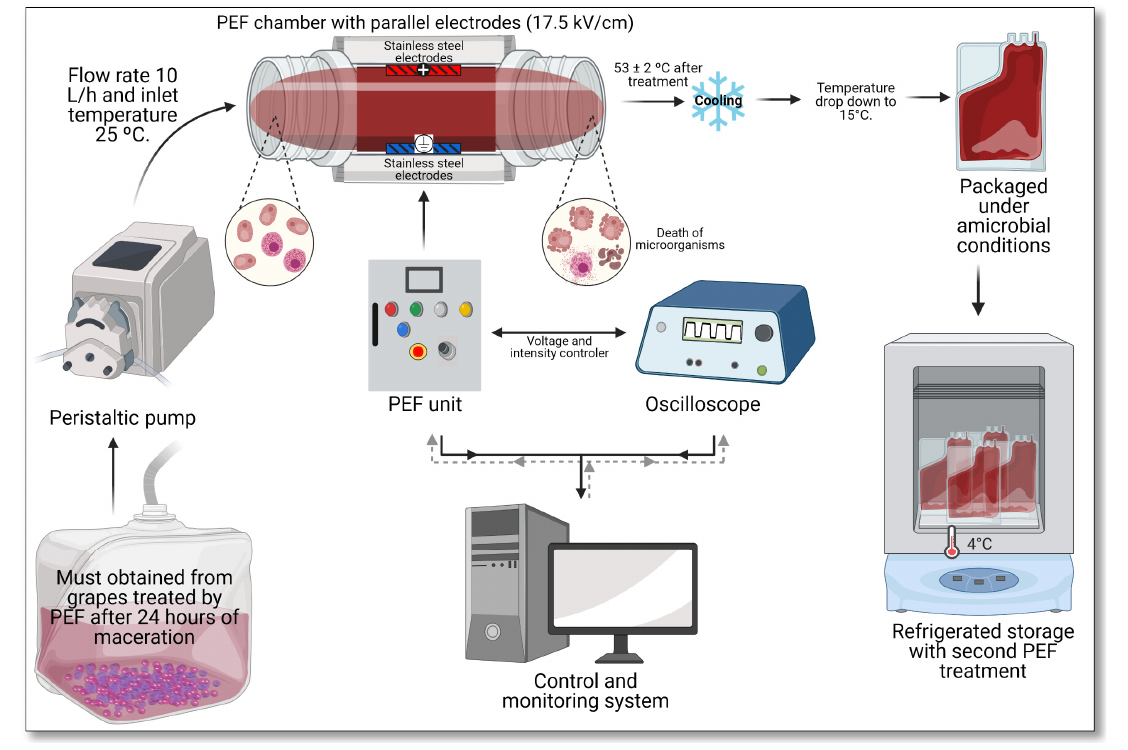
Figure 2. Schematic of the PEF processing of must.